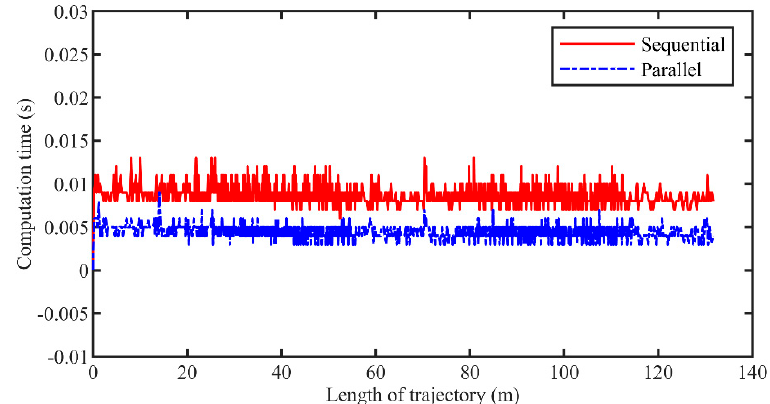
Figure 17. The computation time of the comparison between calculation processes.